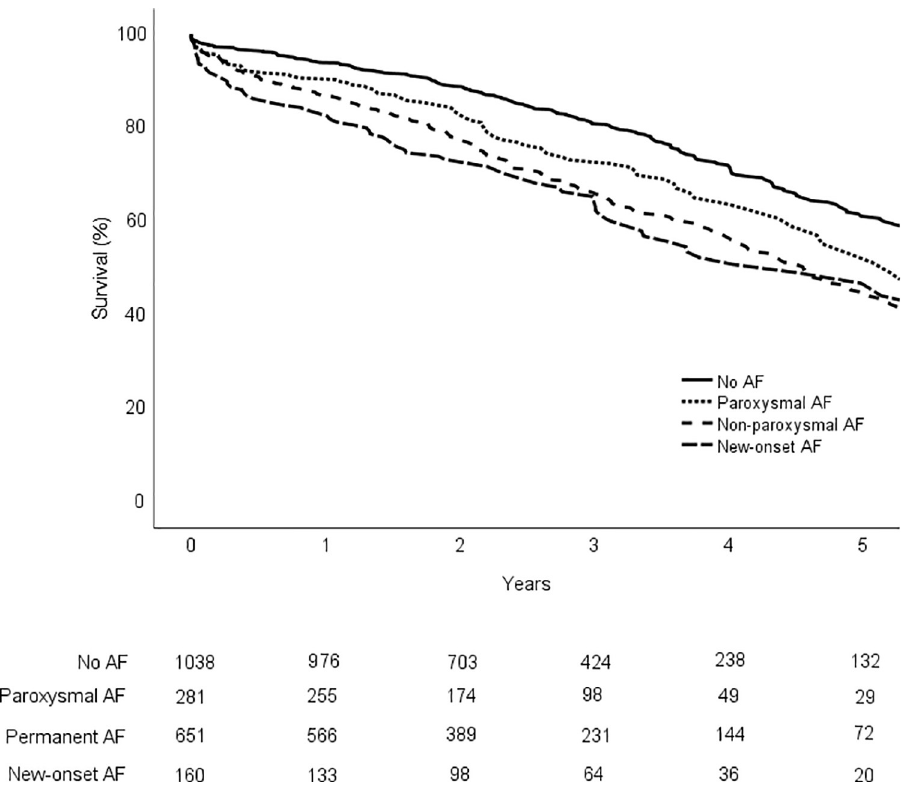
Fig 1. Kaplan-Meier estimate of survival in patients with paroxysmal, non-paroxysmal, new-onset or no AF undergoing transcatheter aortic valve replacement. Number at the bottom of graph are patients at risk.